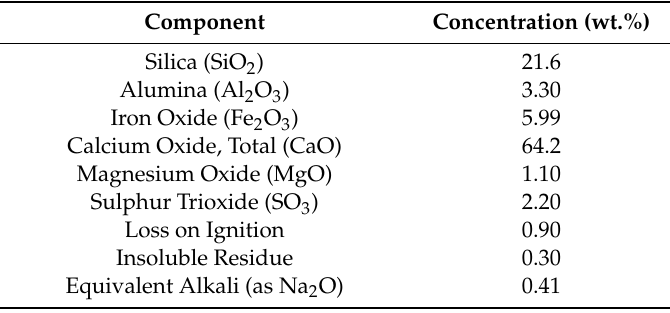
Table 3. Saudi class G cement elemental composition, by X-ray fluorescence (XRF)